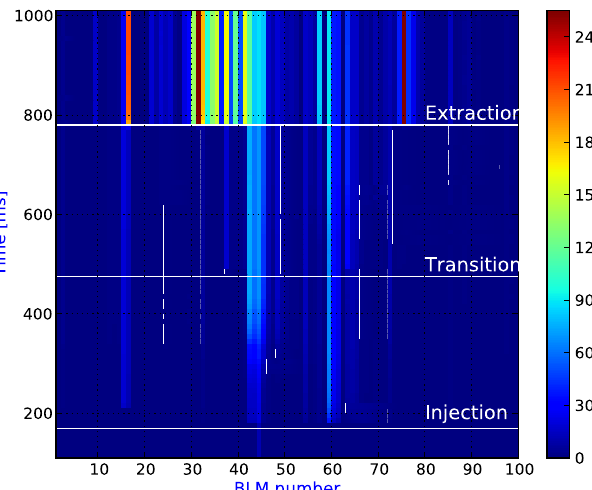
FIG. 18. CT extraction optics for the new QKE16 formed now by quadrupoles in SS25 and SS73. The locations of SMH16 and SEH31 are indicated.